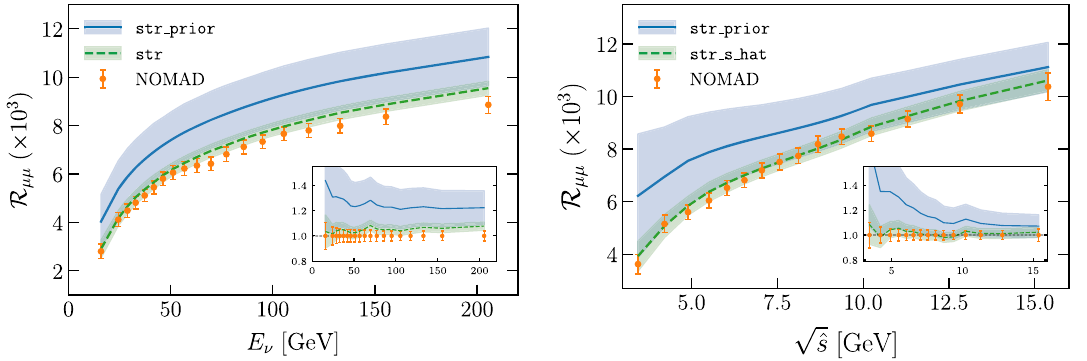
Fig. 2 Comparison between the theoretical predictions, obtained from ments. The insets display the ratio to the central value of each data point. The error bands on the theory predictions indicate the one-sigma the str_prior and str (left) or str_s_hat (right) fits, and the √ ˆ s -dependent NOMAD measure- PDF uncertainties experimental data for the E ν - and